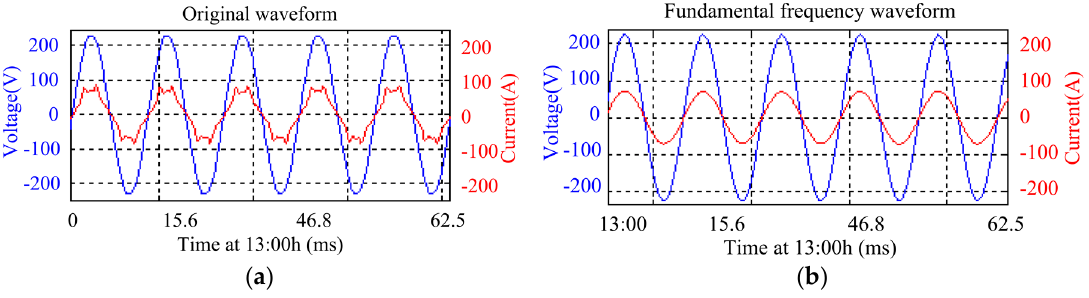
Figure 9. Main board MBD3 voltage and current signals at a time when stationary disturbances are